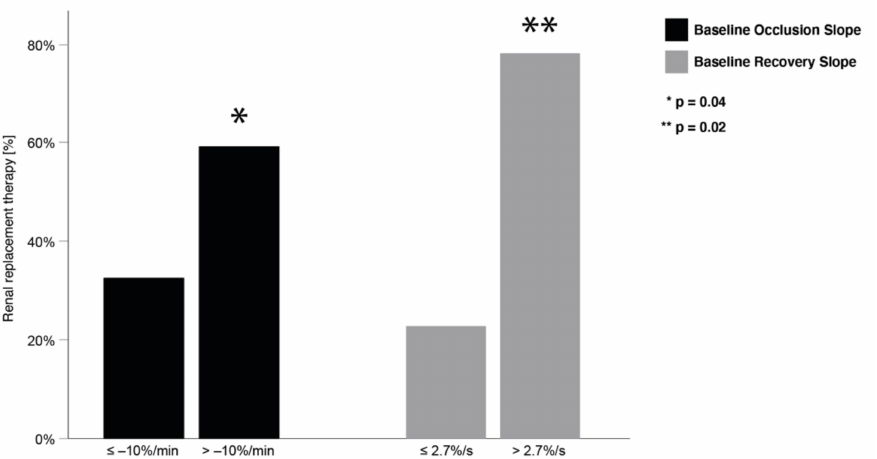
Figure 3. Percentage of patients developing the need for renal replacement therapy in relation to their VOT occlusion slope at baseline; p = 0.045.